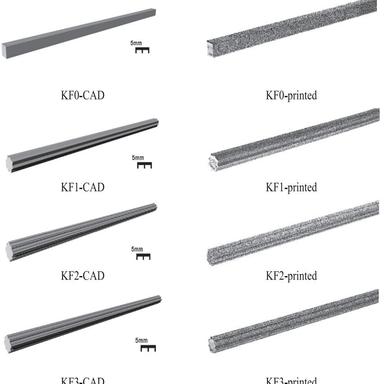
Optical microscope image showing the "as-built" cross section of Koch bar KF3 with an equivalent diameter of 6.01 ± 0.2 mm. Blue insert bars representing regions of KF2 bar are shown for reference. (For interpretation of the references to color in this figure legend, the reader is referred to the web version of this article.)